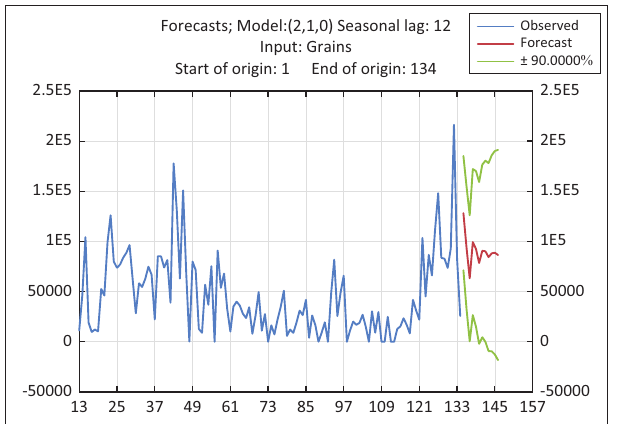
FIGURE 8: Original forecast of maize imports through the bulk grain terminal in the Port of Cape Town.